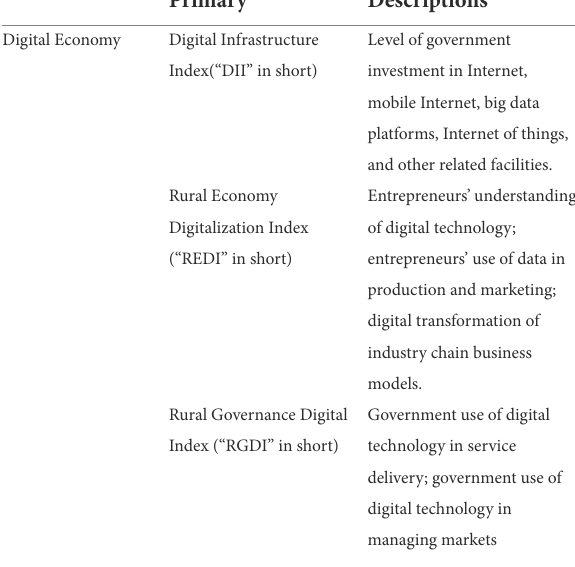
TABLE 1 Dimensions of the digital